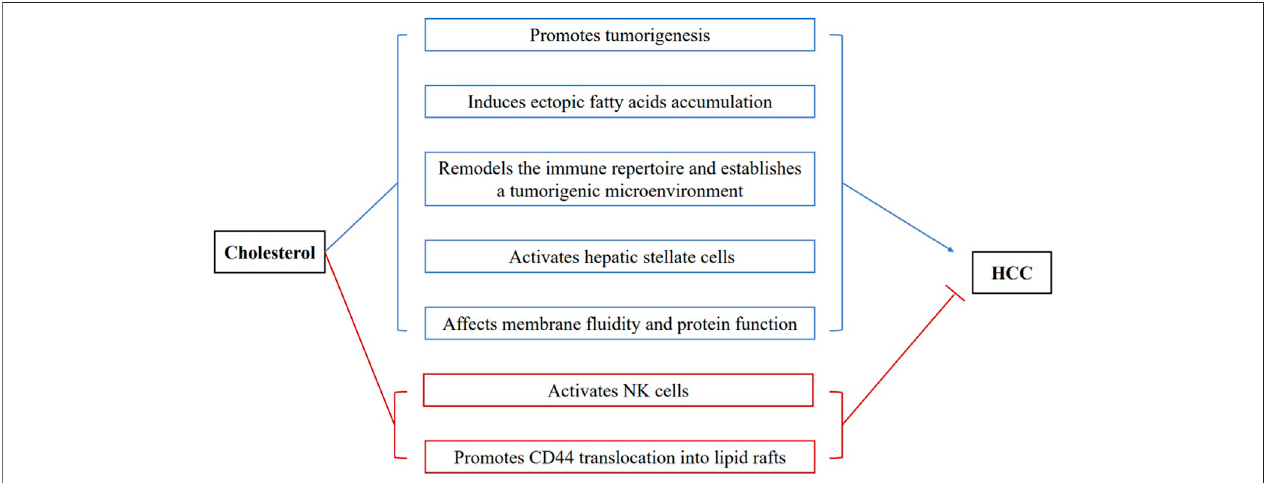
FIGURE 2 | The complex roles of cholesterol in the development of HCC. Proposed mechanisms for the pathogenic roles of cholesterol in HCC are revealed (blue characters): (1) promoting tumorigenesis; (2) inducing ectopic fatty acids accumulation; (3) remodeling the hepatic immune repertoire and establishing a tumorigenic microenvironment; (4) activating hepatic stellate cells; (5) affecting membrane fl uidity and protein function. Mechanisms by which cholesterol inhibits HCC development (red characters): (1) activating NK cells to fi ght against hepatoma cells; (2) promoting the translocation of CD44 into lipid rafts and attenuating CD44-mediated migration and metastasis of